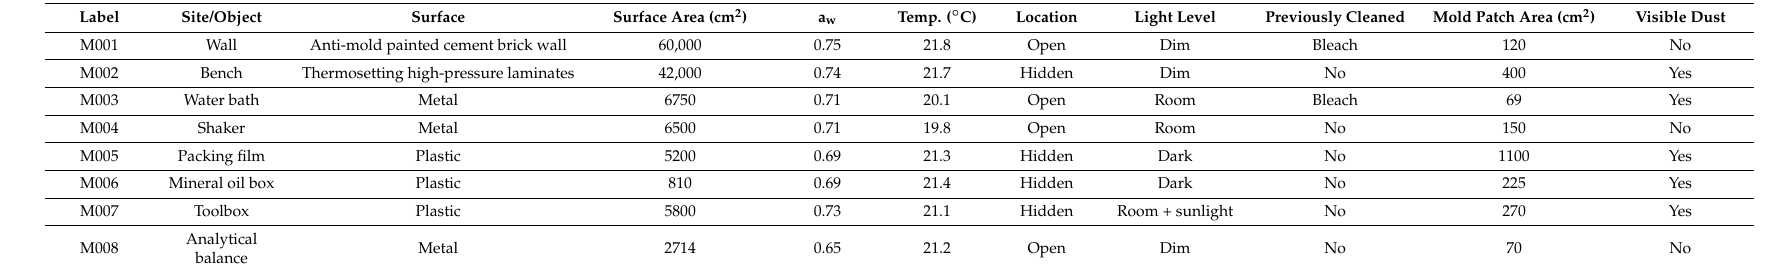
Table 2. Environmental information and conditions in the sample